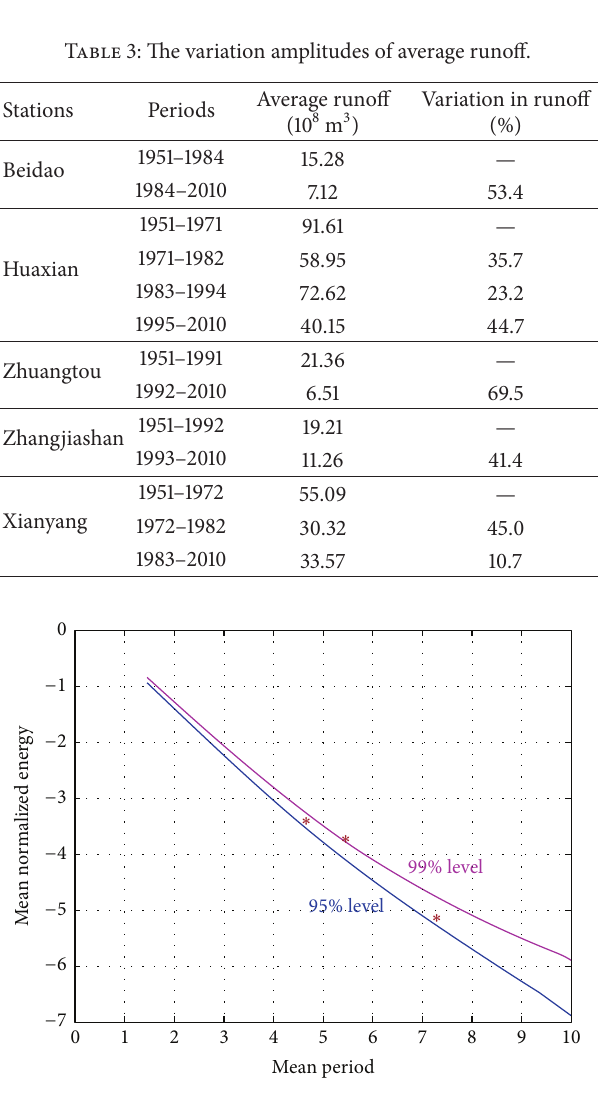
Figure 5: Results of significance test of detected abrupt change points in runoff at